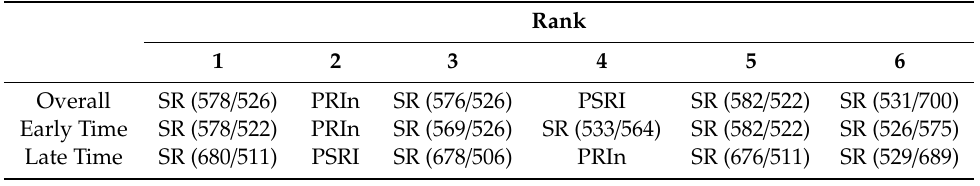
Table 3. Identified features using the new search algorithm for overall (average), early time (first four acquisition dates), and late time (last four acquisition dates) for the entire hyperspectral feature set (~150,000 variables). Note that the second identified feature for each of the time segments is a VI. This strengthened the positions of these